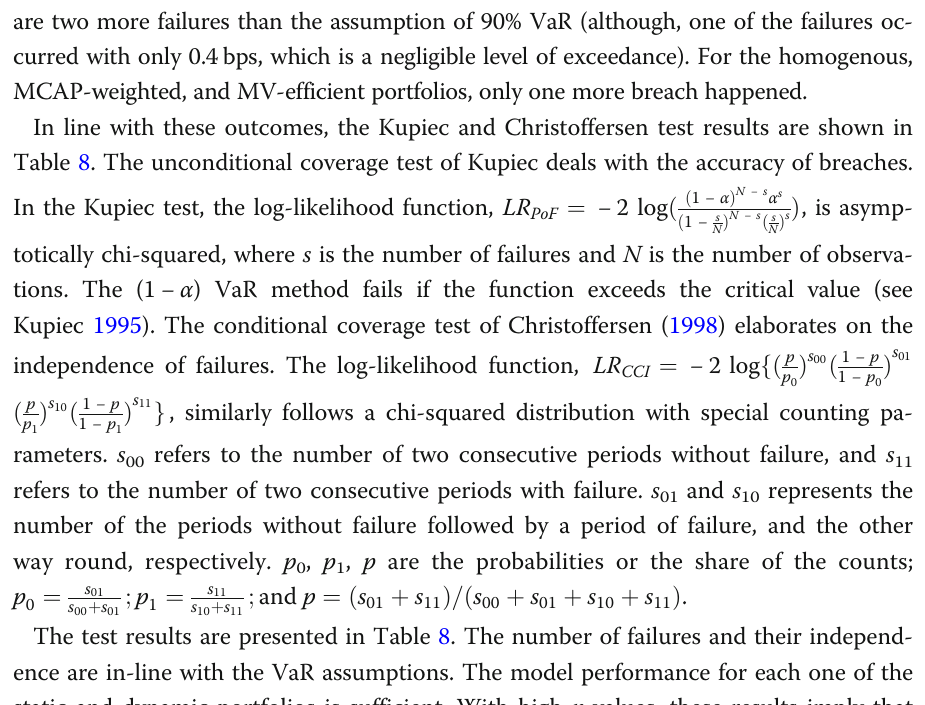
Table 8. The unconditional coverage test of Kupiec deals with the accuracy of breaches. In the Kupiec test, the log-likelihood function, LR PoF ¼ − 2 log ð ð 1